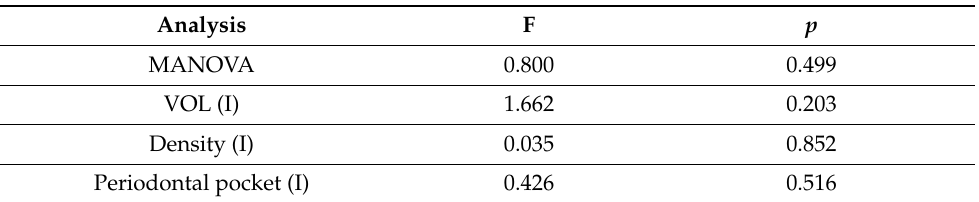
Table 5. Significance of the difference between the groups, in regards to the monitored parameters in the II